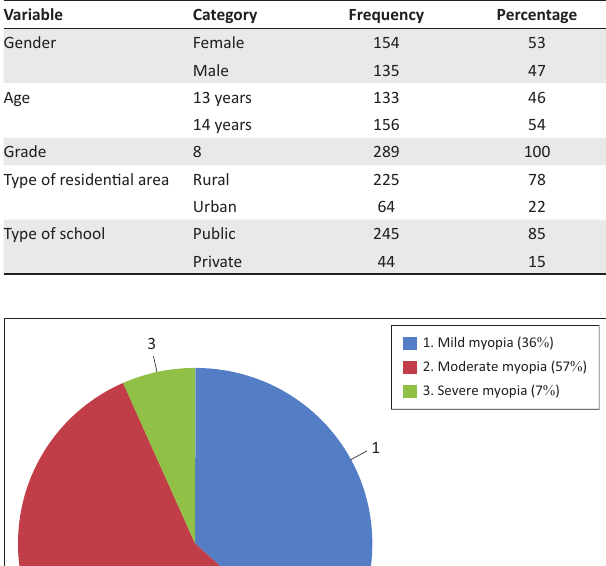
TABLE 1: Demographic characteristics of participants ( N = 289).